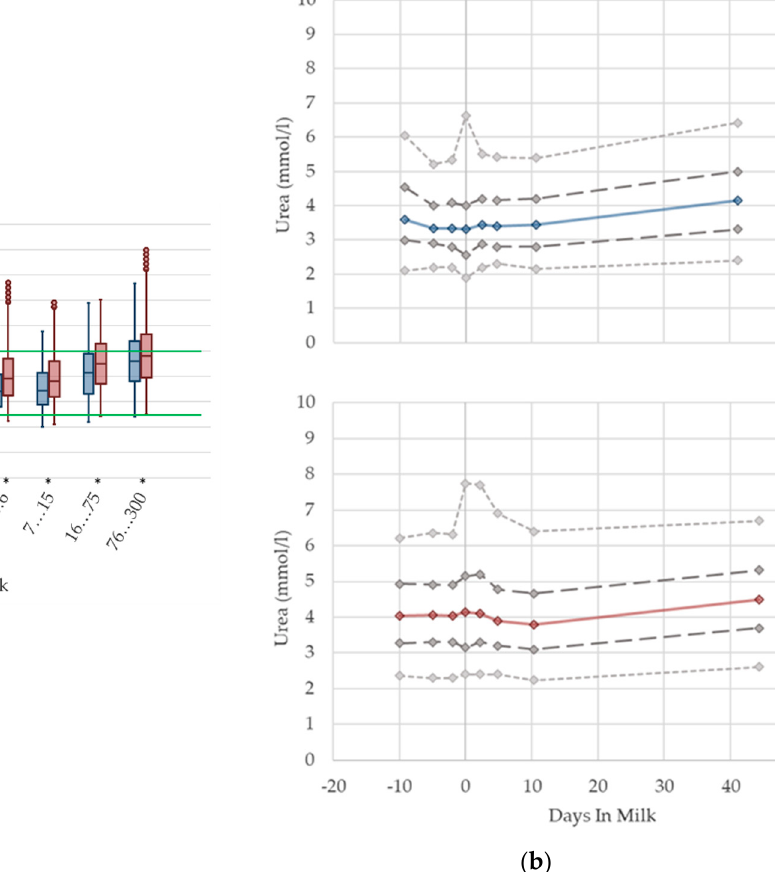
Figure 5. Serum concentrations of urea in primiparous (blue) and in multiparous (red) cows ( a ) in 10 classes between 30 days prepartum to 300 days postpartum (boxplots), green continuous lines represent the reference values according to Fürll [23], asterisk indicates significant differences regarding parity within DIM class; and ( b ) in 8 classes from 10 days prepartum to 40 days postpartum (median—continuous line; 1st and 3rd quartile—dashed lines; percentile 5 and 95—dotted lines).